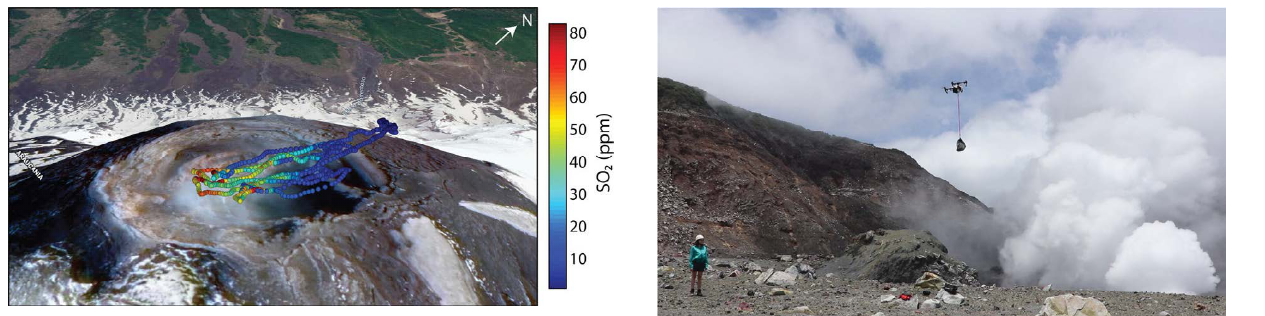
Figure 17: CO 2 sampling from the plume at Poás vol- cano, Costa Rica (2019). The gas sampling payload (550 g) is suspended 1.5 m below the DJI Inspire 1 as it is flown into the plume. The sample is procured by a re- motely operated pump which fills gas bags for isotopic analysis in the